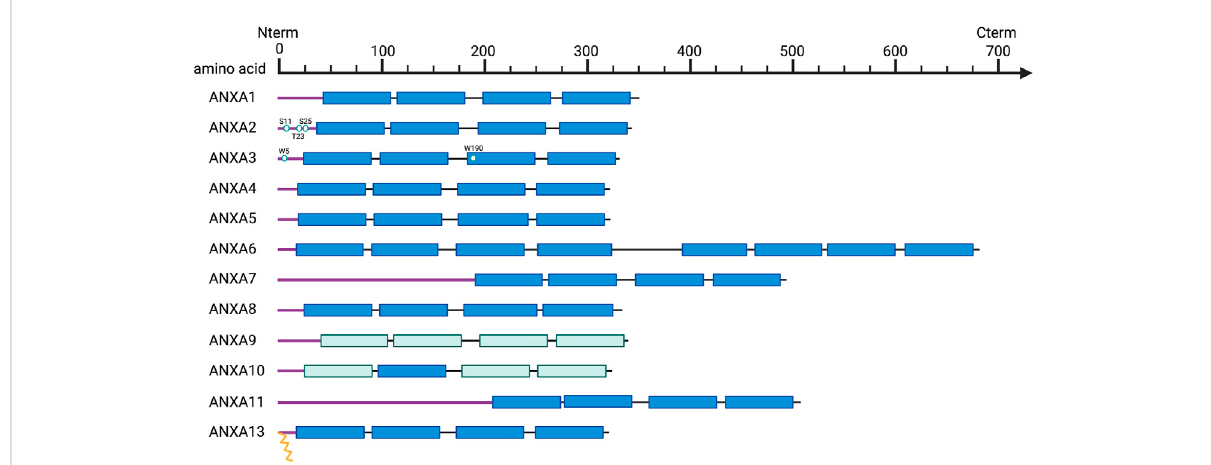
FIGURE 1 Schematicoverviewofannexinstructuralorganization.Purpleline,N-terminaltails;Darkblue,C-terminal coredomainsincludingfourannexin repeats (duplicated to eight in ANXA6); Light blue, annexin repeats harboring non-functional typeII calcium binding sites; Key residues are indicated and represented as spheres, and myristoylation as yellow zig-zag lines.